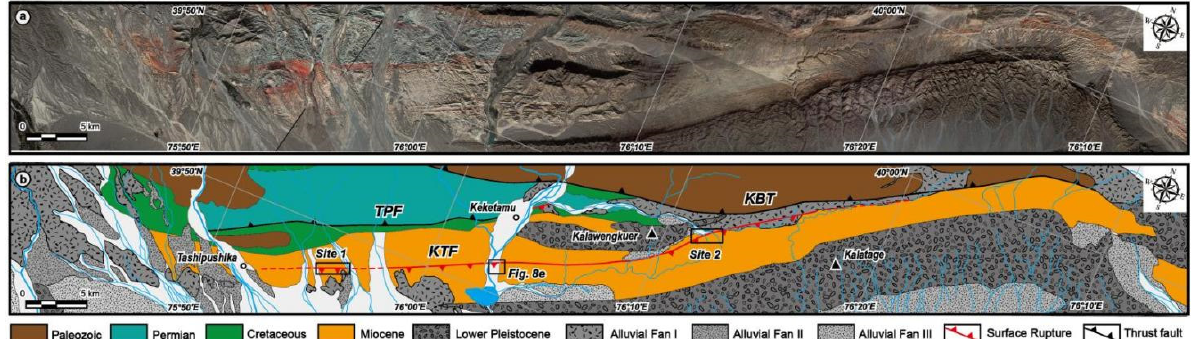
Figure 2. Geometric feature of surface rupture zones along the KTF. ( a ) GF-2 satellite image after fusion of multi-spectral and panchromatic images; ( b ) geological interpretation of the GF-2 satellite image showing the geometric features of the surface rupture zone developed along the KTF.